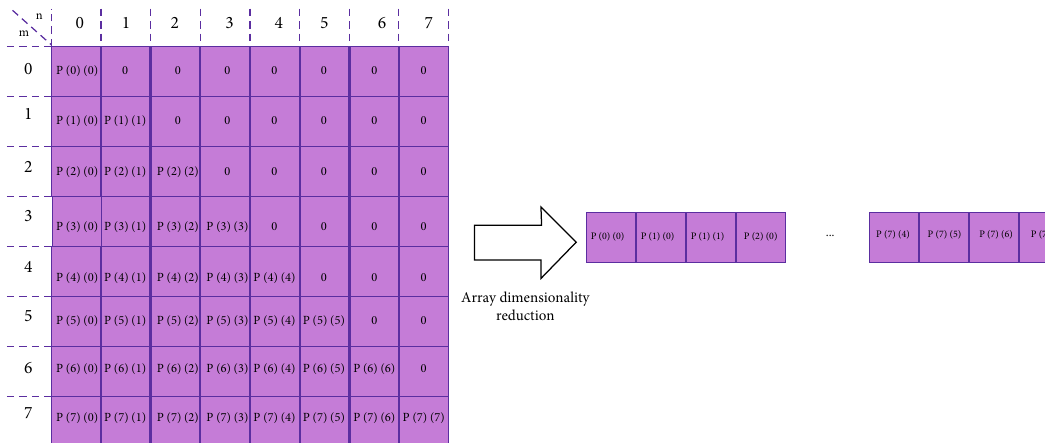
Figure 7: Schematic diagram of the array dimensionality reduction.